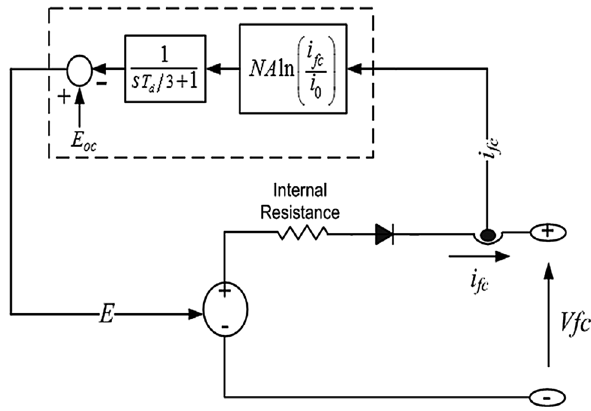
Fig. 2 The equivalent circuit of the FC stack